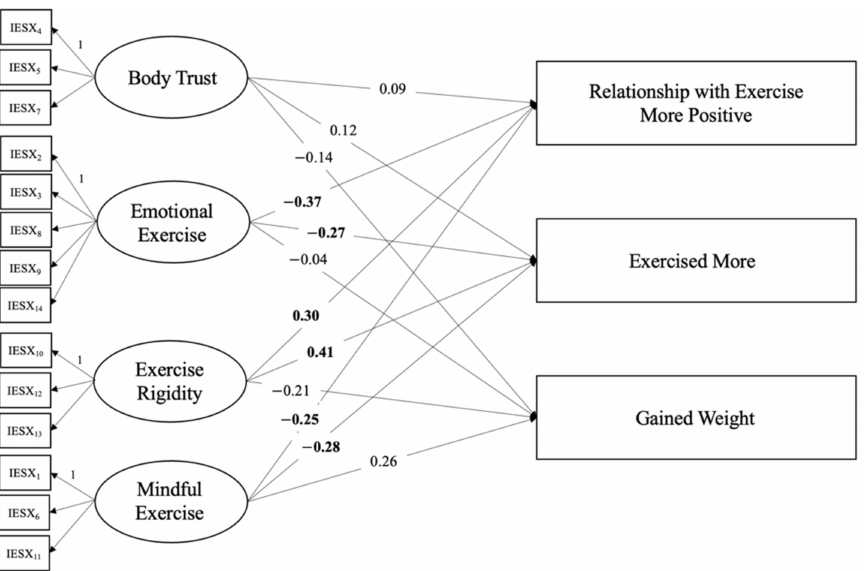
Figure 3. Path analysis results for facets of intuitive exercise during the pandemic and behaviors and attitudes about exercise during the pandemic. Note. The first indicator for each latent variable served as the scaling indicator, represented with a “1”. Coefficients in bold indicate significant paths ( p < 0.05, two-tailed). In this model, latent variables represented intuitive exercise during the pandemic and outcome variables represented attitudes/behaviors about exercise during the